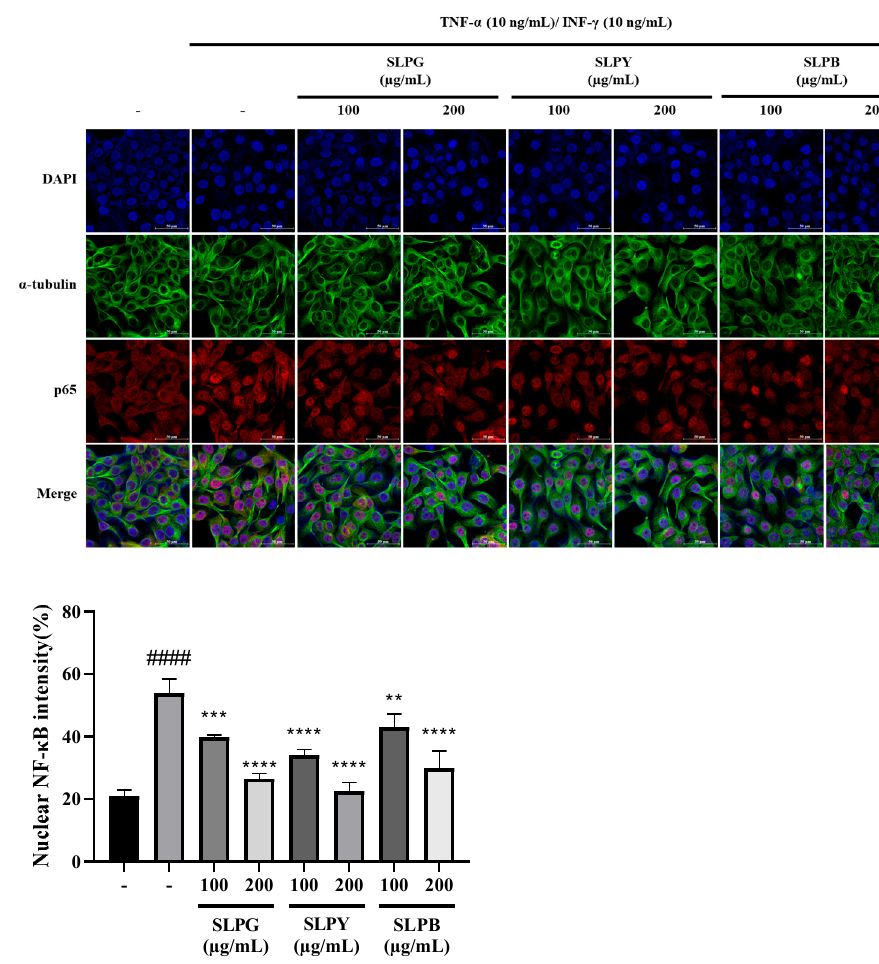
Figure 2. Immunofluorescence staining of TNF- α /INF- γ co-stimulated HaCaT cells treated with powdered by-products of silkworm larvae. NF- κ B activation was assessed by immunostaining for p65 intracellular localization (red) overlaid with 4 ′ ,6-diamidino-2-phenylindole dihydrochloride (DAPI) nuclear stain (blue); the green color represents α -tubulin. SLPG: steamed and freeze-dried powdered by-product of mature silkworm larvae of the Golden Silk strain; SLPY: steamed and freeze-dried powdered by-product of mature silkworm larvae of the Yeonnokjam strain; SLPB: steamed and freeze-dried powdered by-product of mature silkworm larvae of the Baekokjam strain. #### p < 0.0001 vs. the corresponding control group and ** p < 0.01, *** p < 0.001, **** p < 0.0001 vs. the corresponding TNF- α /INF- γ treated group.